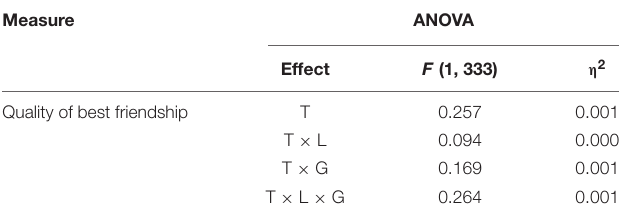
TABLE 5 | ANOVA statistics on friendship quality. Measure ANOVA Effect F (1, 333) η 2 Quality of best friendship T 0.257 0.001 0.001 0.264 0.001